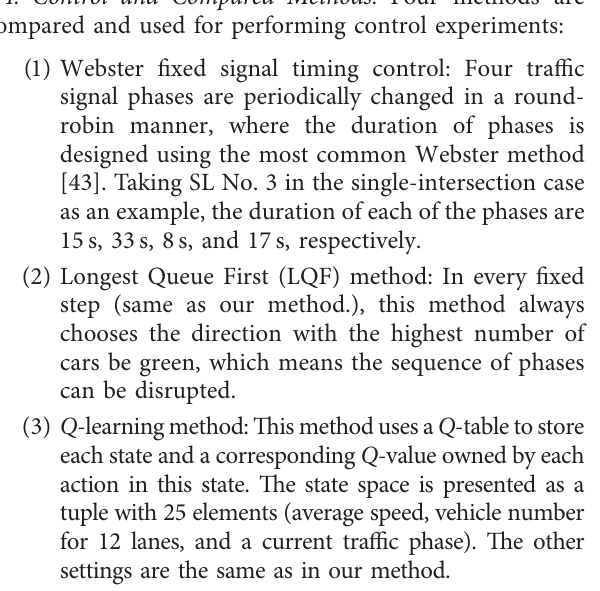
Number of steps to observe before training process. Number of steps the agent trains.